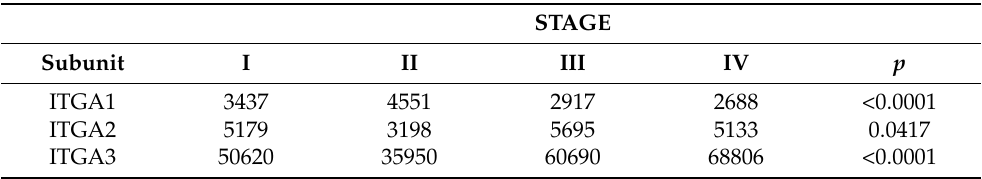
Table 2. Mean gene expression and ANOVA analysis of the correlation with disease stage. Only significant data are reported. Stage IV included both IVA and IVC.